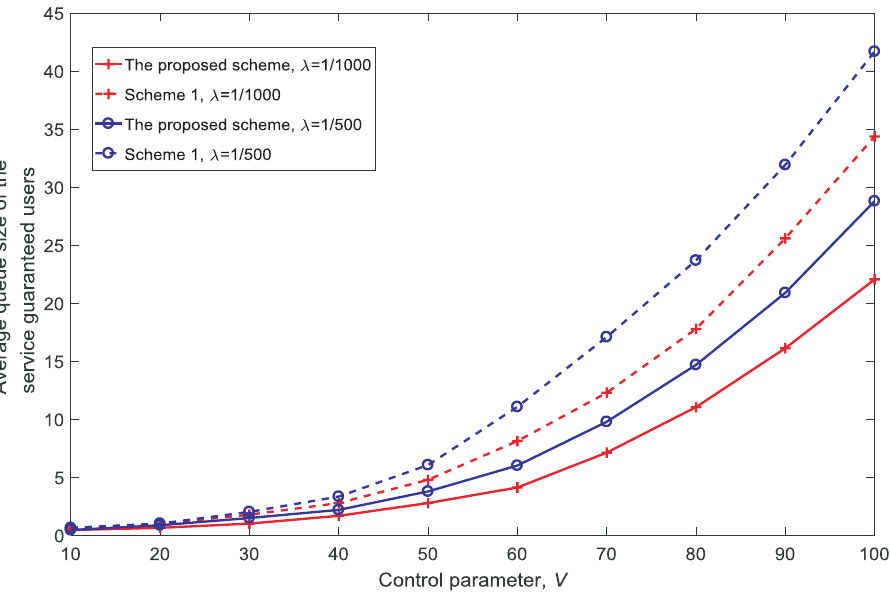
Figure 15. Average queue size of the service-guaranteed users for different control parameter values V ( d V = 10, K = 3, N = 5 )